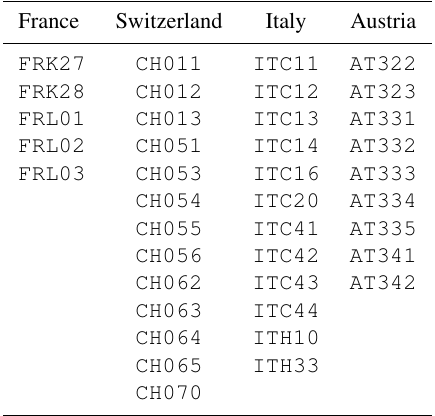
Table A1. NUTS 3 units used for the definition of the Alps region and divided by country.